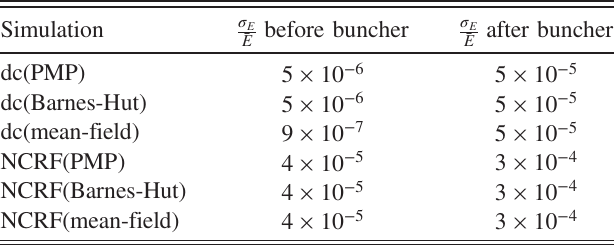
TABLE III. Slice energy spread in 0 meV MTE